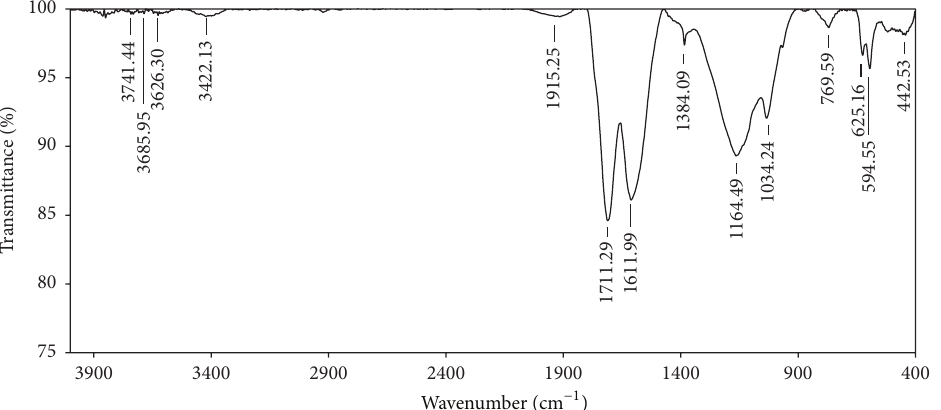
Figure 2: FTIR spectra of lead ion loaded